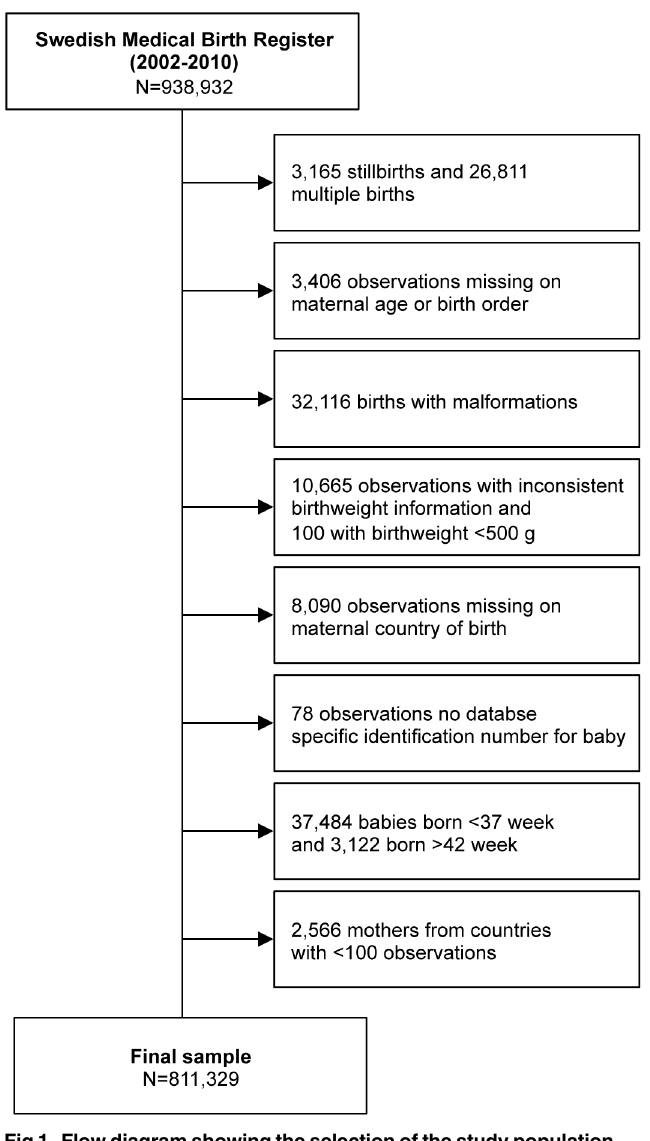
Fig 1. Flow diagram showing the selection of the study population.